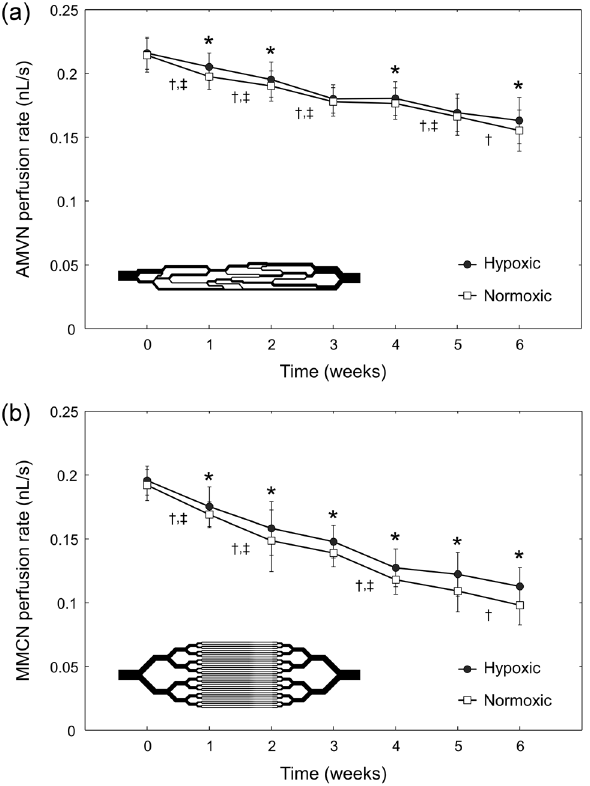
Figure 3. The change in (a) AMVN and (b) MMCN perfusion rates for RBCs stored under normoxic and hypoxic conditions over the course of 6-week hypothermic storage. Values shown are mean ± standard deviation (n = 9). Statistically significant differences ( p < 0.05) between hypoxically and normoxically stored RBCs of the same storage duration are marked by an asterisk (*). Statistically significant differences ( p < 0.05) between subsequent weeks of storage are marked by a dagger (†) for normoxically stored RBCs and a double dagger (‡) for hypoxically stored